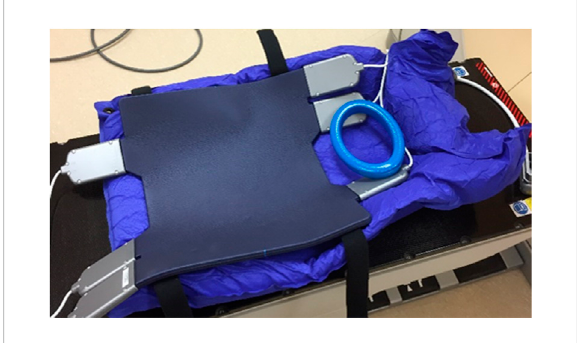
FIGURE 1 Blue bag immobilization device, for patient setup in head fi rst supine position with their arms up holding onto the blue ring. Notably, the posterior coil is embedded into the blue bag for reproducible coil and patient